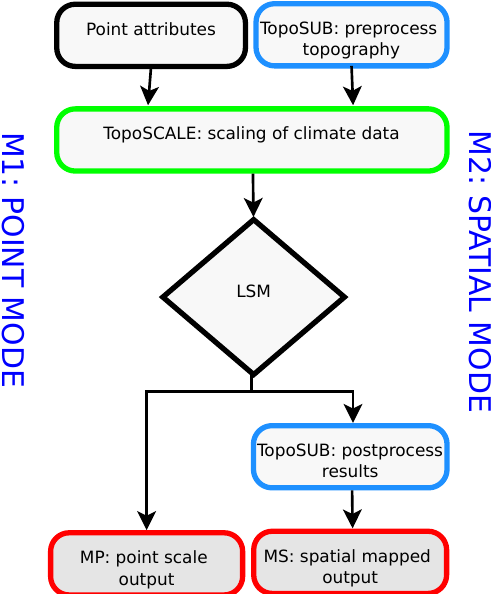
Figure 1. Overview of how the model chain of TopoSUB, TopoSCALE and LSM operate together. Two main modes of op- eration, (MP) point and (MS) spatial, are